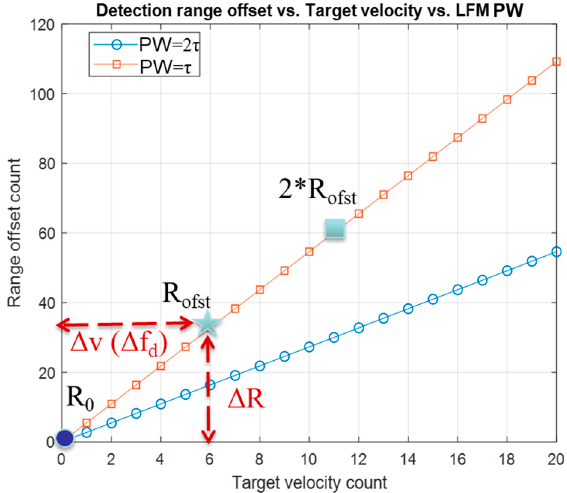
Figure 3. The linearity between target velocity and convolution range offset of a single chirped LFM waveform. The orange-squared line is the steeper chirping slope signal with pulse width (PW) = 2 τ while the shows the flatter chirping slope signal with PW = τ in blue-circle line.